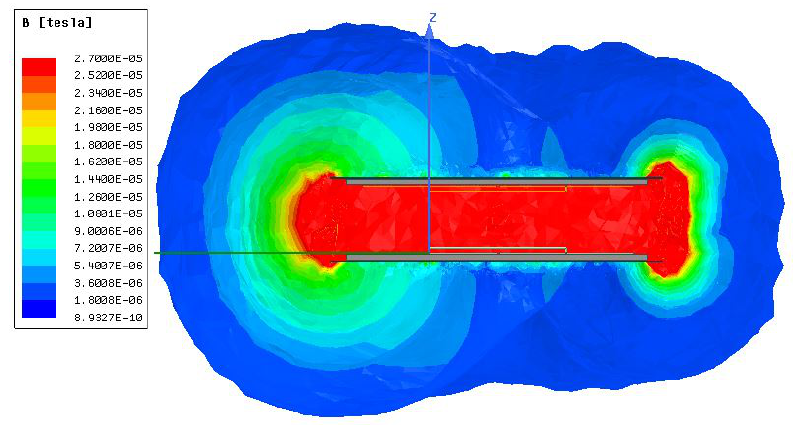
Figure 10. Magnetic field intensity plot of the inductive link with ferrite and shielding layers.